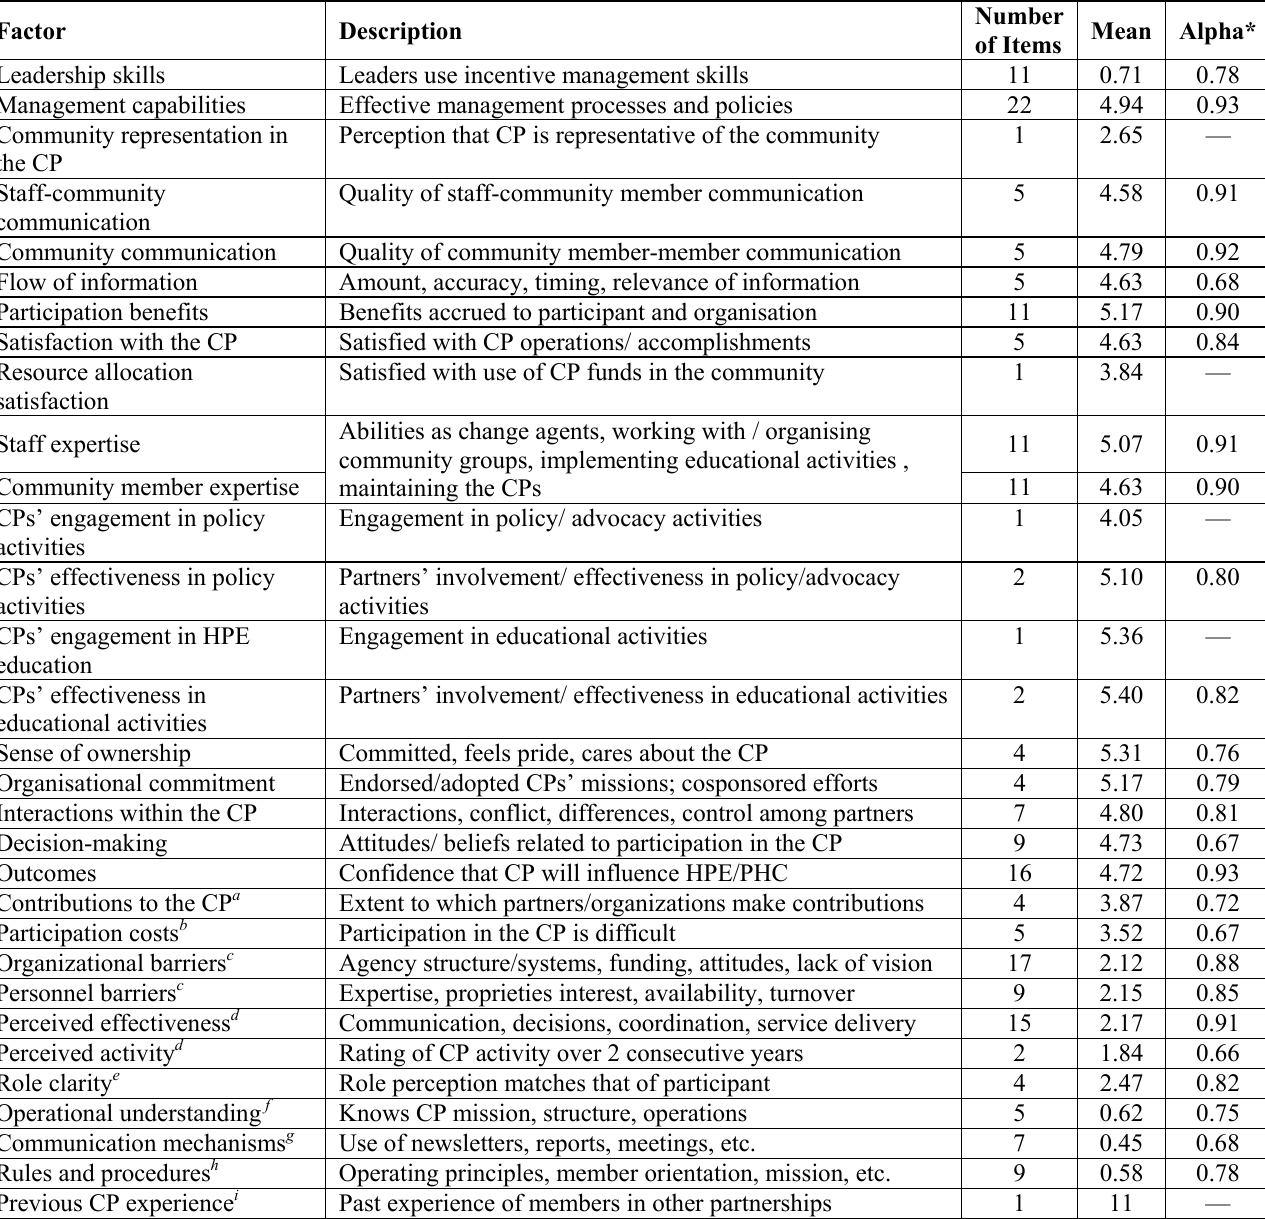
Table 1. Community partnerships: factors, † their description and